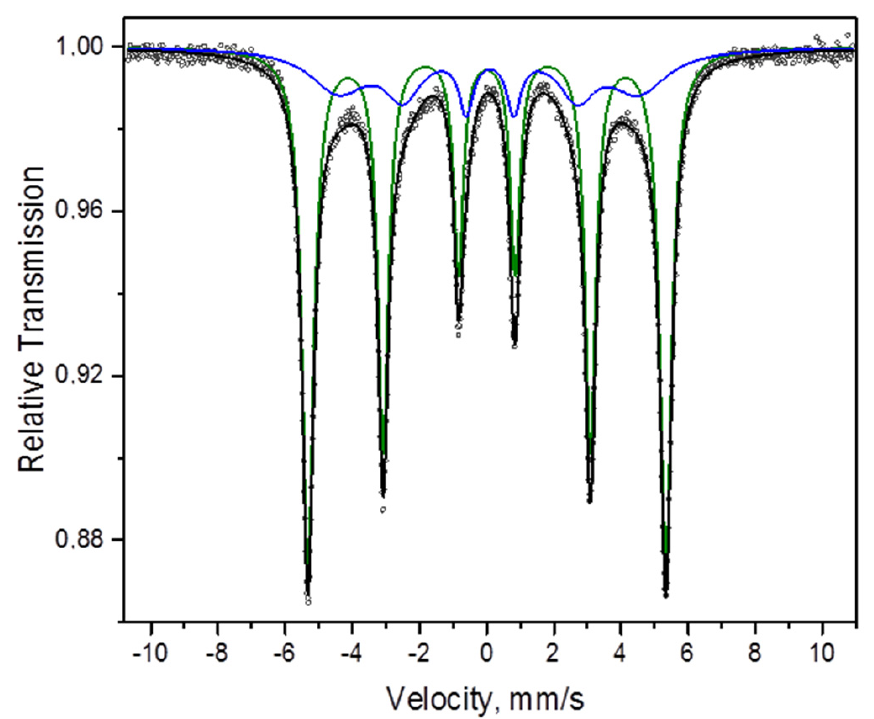
Figure 3. Mössbauer spectrum of the carbonyl iron powder: dots—experimental data, black line—spectrum represented as a superposition of two sextets (green and blue lines).